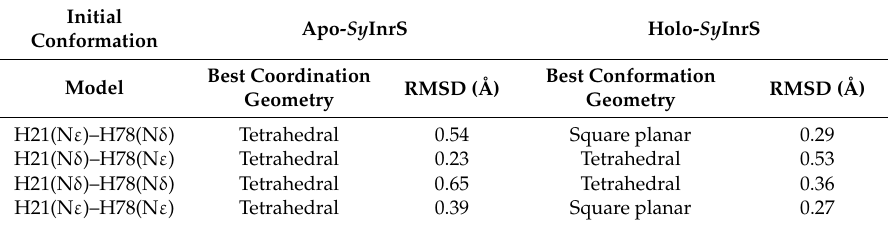
Table 3. Analysis of the metal binding sites in the Sy InrS Ni(II) bound models.